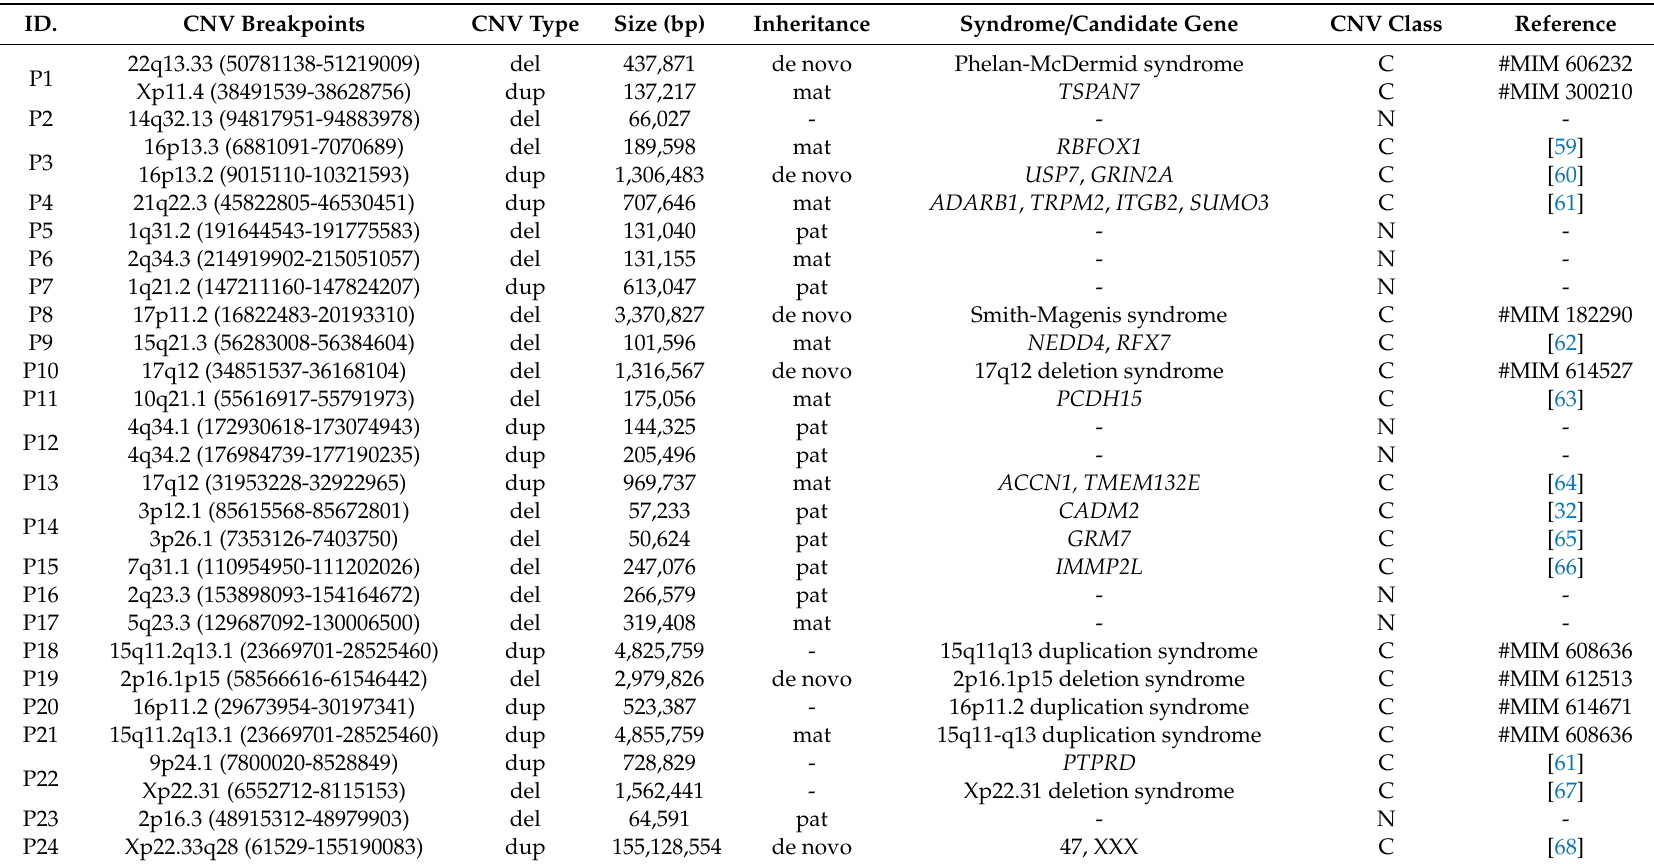
Table 1. Chromosomal microarray (CMA) results in the 29 participants carrying at least one Copy Number Variant (CNV). For each participant with positive CMA results are reported the genomic location and breakpoints of each CNV, the CNV subtype (deletion or duplication), the size in base pairs, the inheritance status, the associated known genetic syndrome or Autism Spectrum Disorders (ASD) candidate genes involved in the rearrangement, and the CNV classification (causative or